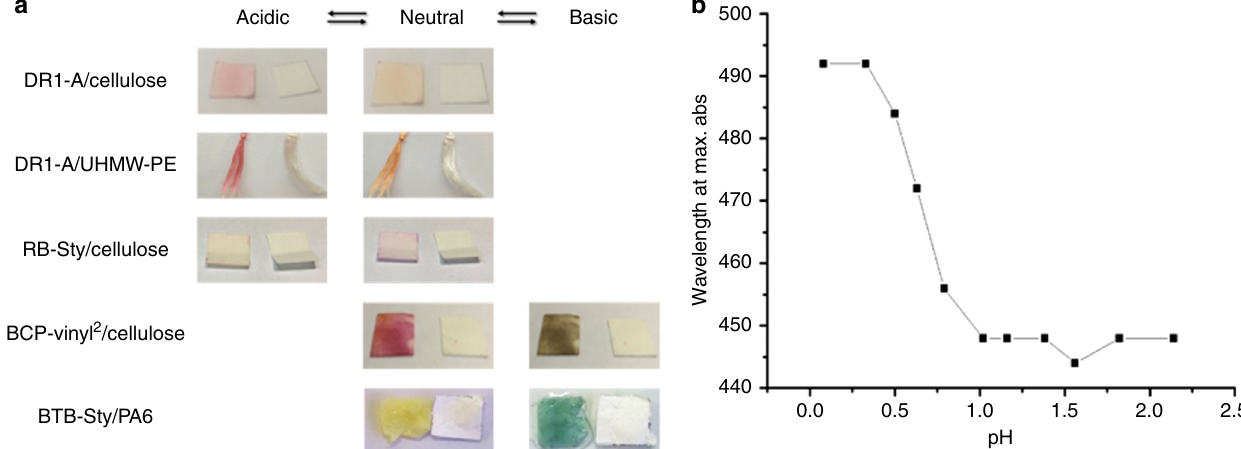
Fig. 9 The halochromic behavior of plasma dye coated materials. a The halochromic behavior of these materials is induced by the application of HCl or NH 3 saturated vapor in the case of DR1-A, RB-Sty, and BCP-vincyl 2 or aqueous solutions in the case of BTB-sty. Each sample is photographed compared to an untreated reference sample. b Wavelength at max. absorbance in function of the pH dipping solution prior to re fl ective UV-VIS measurements of cellulose/ DR1-A allowing the estimation of the pKa of DR1